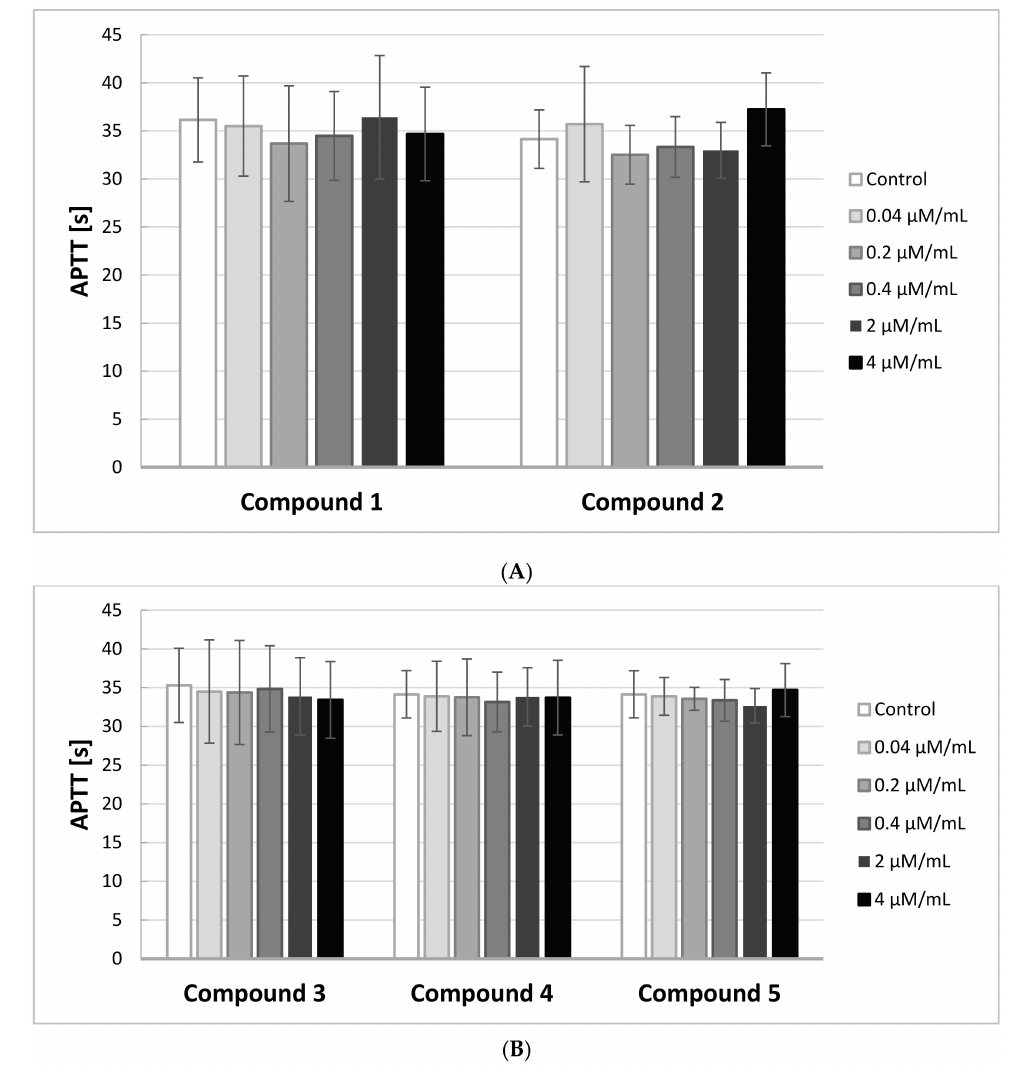
Figure 4. The effects of iminodiacetic acid derivatives ( A ) compounds 1 and 2 ; ( B ) compounds 3 – 5 on Activated Partial Thromboplastin Time (APTT) (mean ± SD; n = 5) after 3 min incubation in plasma; final volume 160 µ L. Exposure to the tested compounds even at the highest concentrations was shown not to significantly influence the value of APTT over the whole concentration